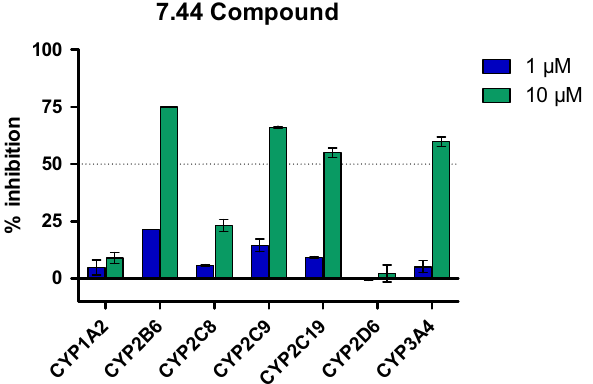
Figure 7. Cytochrome P450 (CYP) inhibition assay for 7.44 . The inhibition assays were performed for seven CYP enzymes at two different concentrations, 1 µM (blue) and 10 µM (green). 7.44 showed a potential to inhibit CYP2B6, 2C9, 2C19, and 3A4. For the other tested enzymes, CYP1A2, 2C8, and 2D6, the potential is regarded low (with estimated IC 50 values > 10